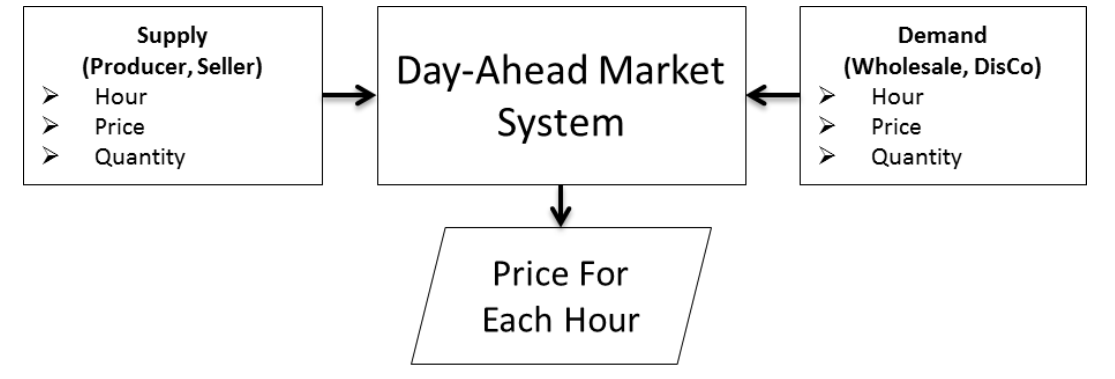
Fig. 1. Day-ahead electricity